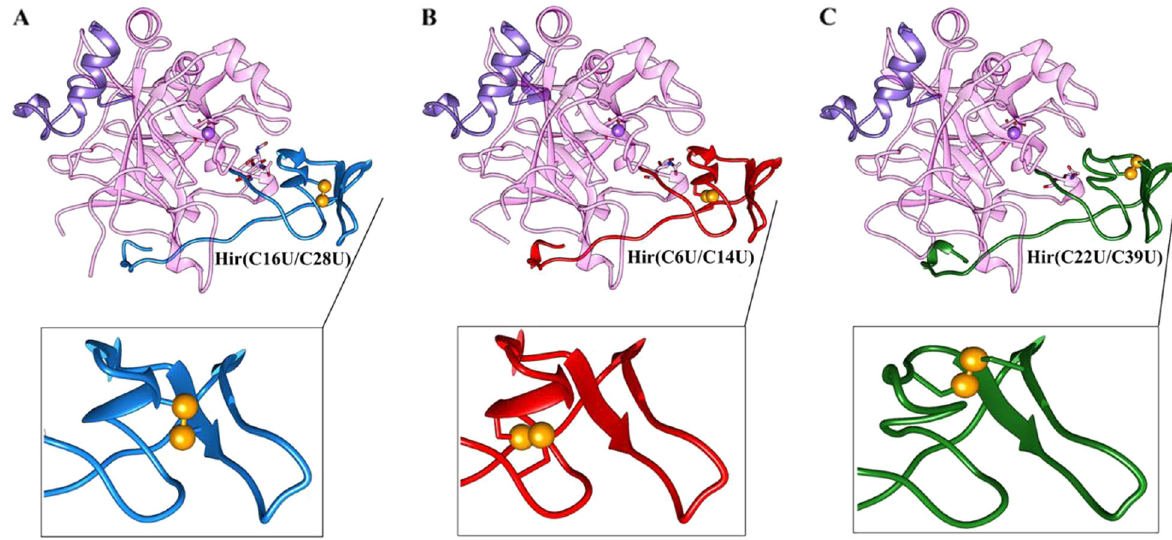
Fig. 5 The overall structures of the three Se-Hir-thrombin complexes. A Complex-1; B Complex-2; C Complex-3. All complexes are shown in the same orientation, where the thrombin active site is at the bottom-right, opening to the right. Colour codes: thrombin heavy chain (Orchid); thrombin light chain (purple); Hir(C16U/C28U) (blue); Hir(C6U/C14U) (red); Hir(C22U/C39U) (green). Gold spheres represent the Se atoms and the Se – Se bonds. A zoom onto the Se – Se bond is shown at the bottom of each structure, in a slightly different orientation where the diselenide bond is best viewed. The PDB IDs for Complexes 1 – 3 are 7A0D, 7A0E and 7A0F,